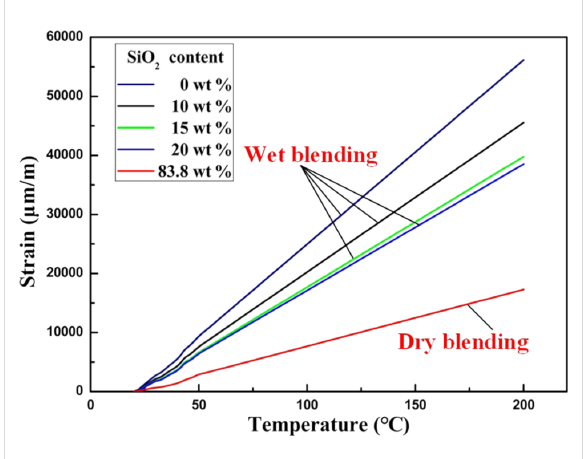
Figure 4: Strain–temperature curves of PDMS/SiO 2 composite tem- plates prepared via dry blending and wet blending.